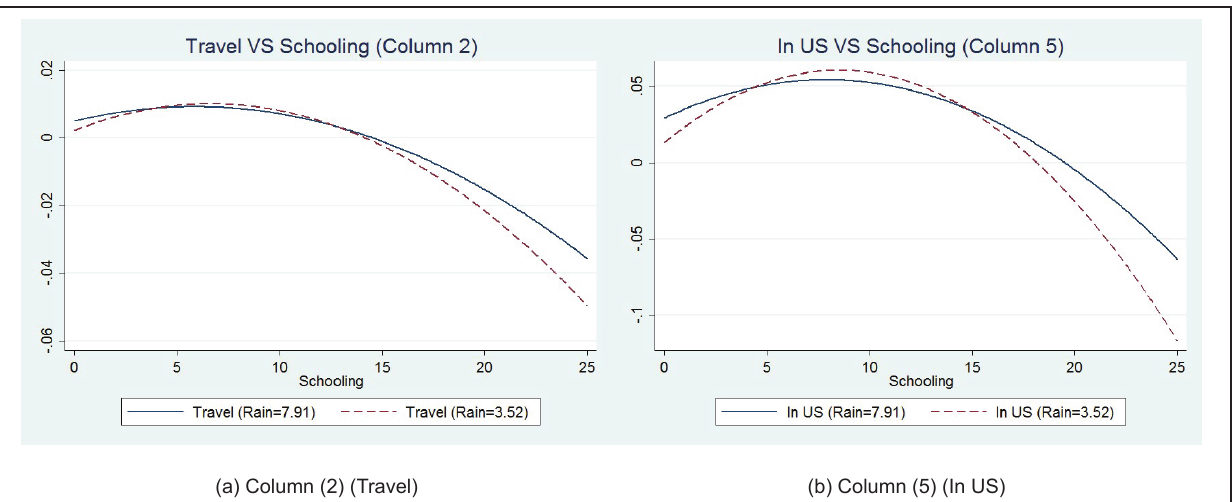
Figure 2 The inverted U relationship between years of schooling and migration probabilities changes with